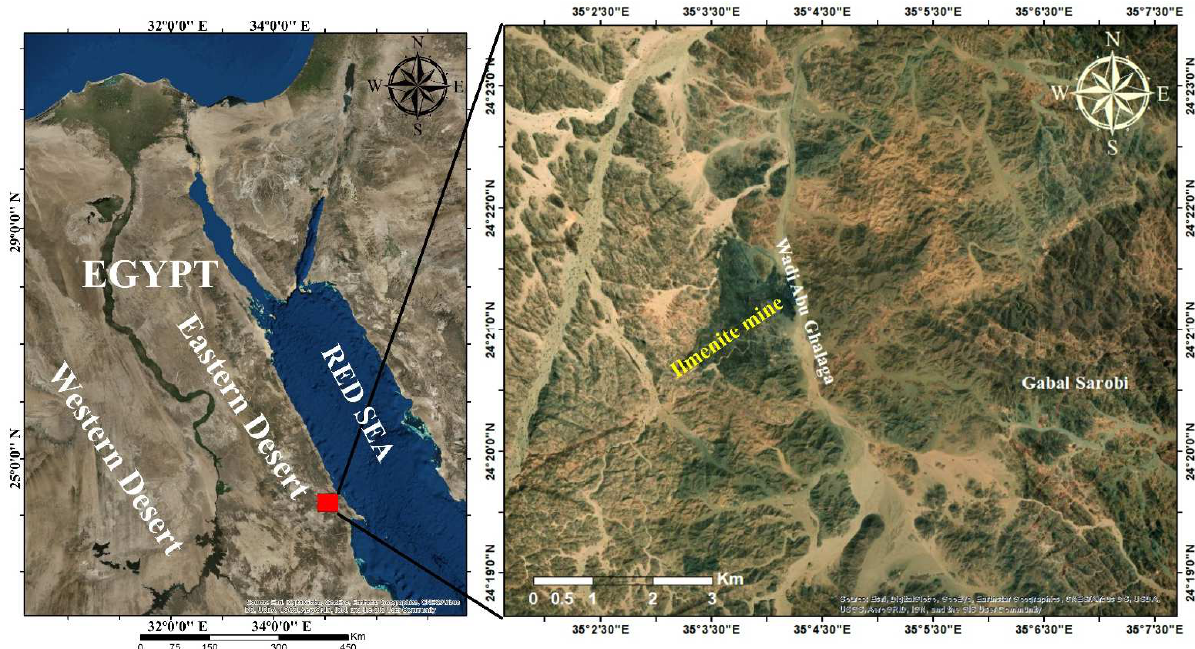
Figure 1. Location map of Wadi Abu Ghalaga.